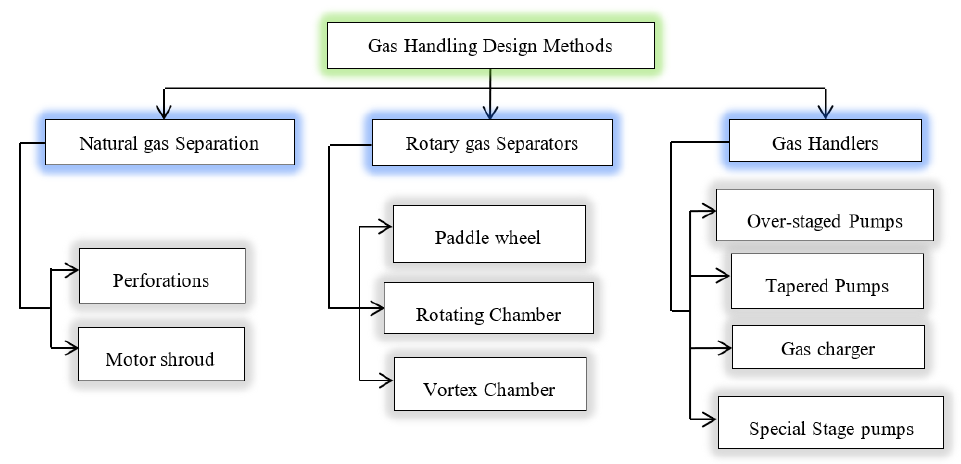
Figure 13. Flow chart of design methods to increase the gas–liquid two-phase handling ability of ESP.